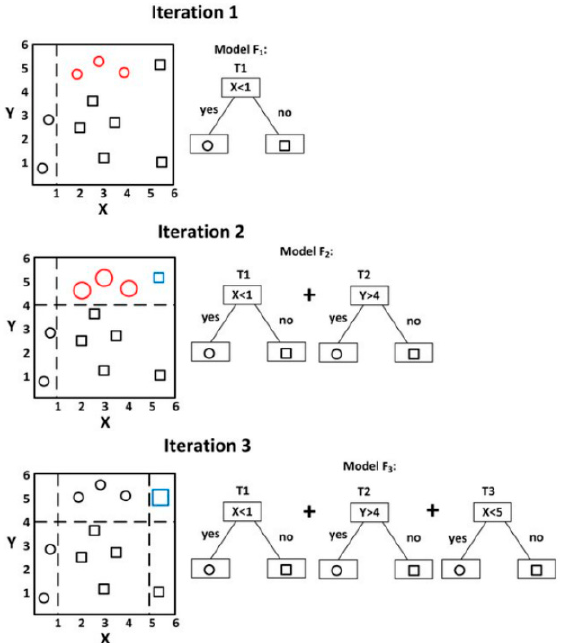
Figure 2. Example of visualizing gradient boosting, source: Zhang et al. [33].